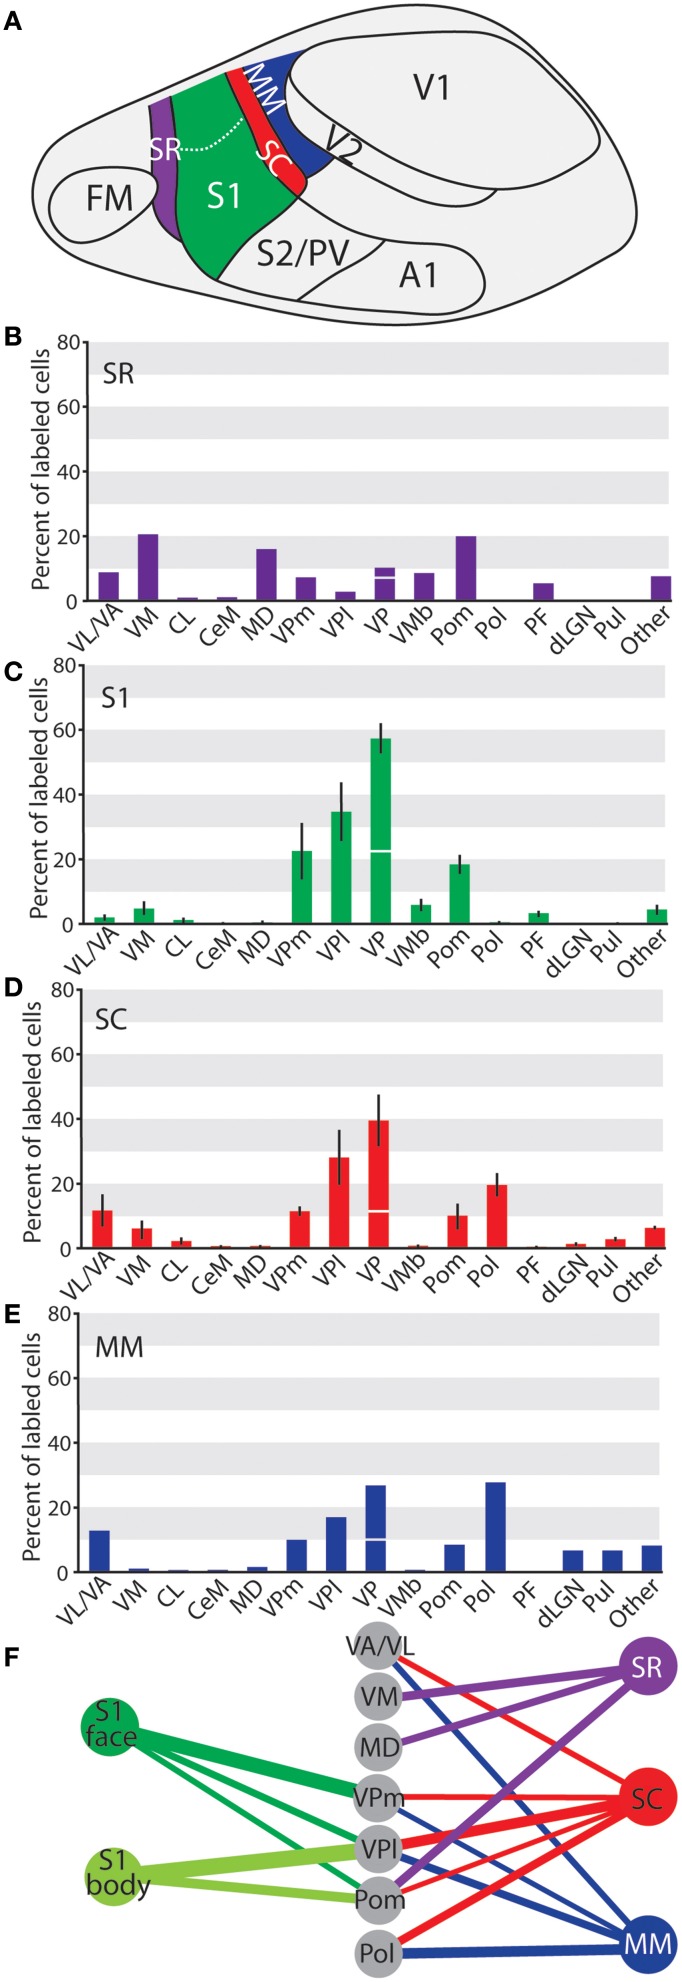
Summary of projections across cortical areas investigated in these studies. (A) Illustration of cortical areas, using the same colors as the graphs and diagrams below. Percent of labeled thalamic neurons projecting to (B) SR, (C) S1, (D) SC, and (E) MM. Data are mean ± SEM when applicable. Axes are the same throughout A-D to aid in comparison. Projections to VPm and VPl are summed above VP, with the projections from VPm under the horizontal line and the projections from VPl above the line. (F) Summary of strong projections from the 5 cortical areas discussed throughout the paper. All projections shown make up > 10% of the total thalamic projections to that area.